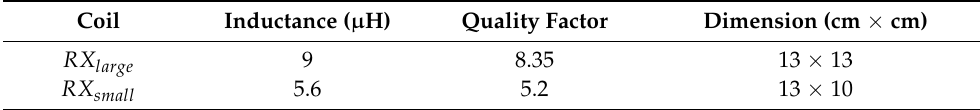
Figure 7. Charging profile of LTC4124. Table 1. Properties of individual coils in the embroidered RX coil array.